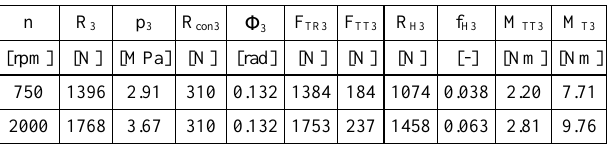
Table 1. Calculated values of forces R 3 , R con3 , F TR3 , F TT3 and R H3 , average contact stress p